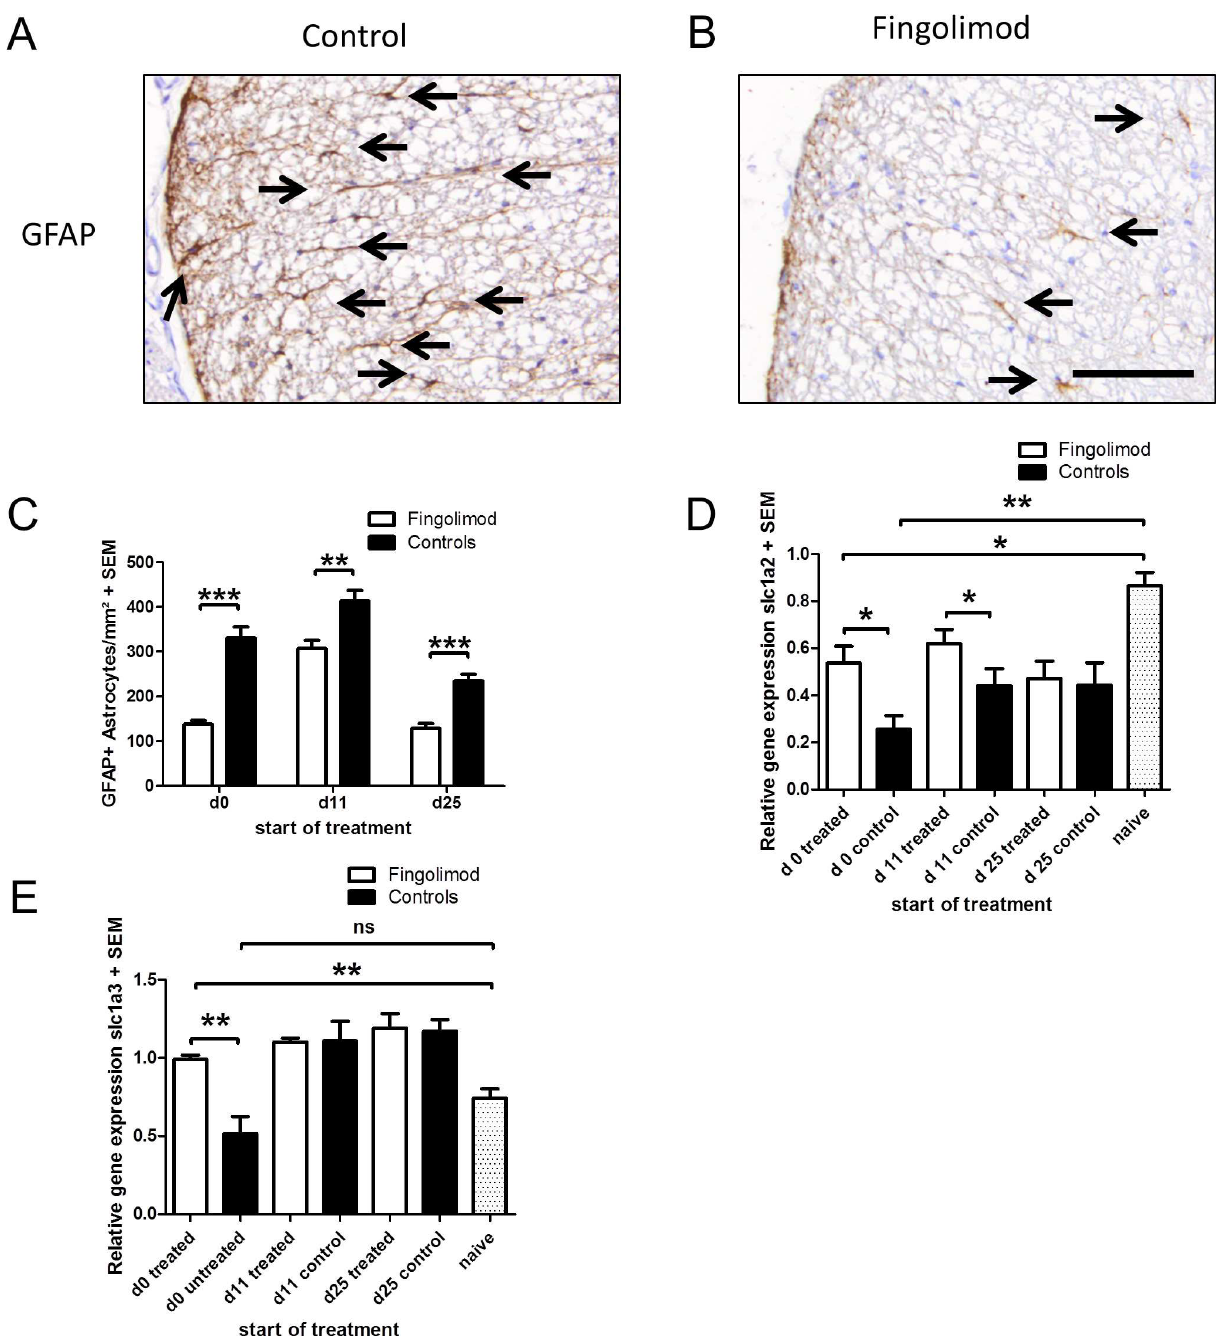
Fig 3. Effects of fingolimod on astrocyteactivation and glutamate transporter mRNA levels in the spinal cord during EAE. (A, B) Representative GFAP staining of spinalcord cross sections from a mouse treated with fingolimodin a preventive setting and a sham treated controlat the maximumof EAE. Note the reducedGFAP stainingafter fingolimodtreatment. Bar = 100 µ m(C) Blindedquantification of GFAP immunreactivity as marker of astrocyte activationon spinalcord cross sections. (D) RT-PCR analysisof slc1a2 expression.(E) RT-PCR analysisof s lc1a3 expression,n = 6–8per group. The mRNA expressionof a prophylactically treated mouseis set to 1 as reference. All data are givenas mean ± SEM. Please note that data are compiledfrom separate experiments with differentstarting points of fingolimodapplication (d0, 11 or 25). The day (d) on the X axis indicatesthe start of treatment directlyafter immunization (d0, n = 6 mice per group), at the first sign of symptoms (d11, n = 6 mice per group)or at the early chronic phaseof the disease(d25, n = 8 mice per group).Experiments were analysedat the maximum of disease(days 15 or 17 p.i., respectively) for treatment start on day 0 and 11 p.i. and in the later chronicphaseof EAE (day 80 p.i.) after treatment start on day 25 p.i. * p < 0.05, ** p < 0.01; *** p < 0.001, MannWhitney test.